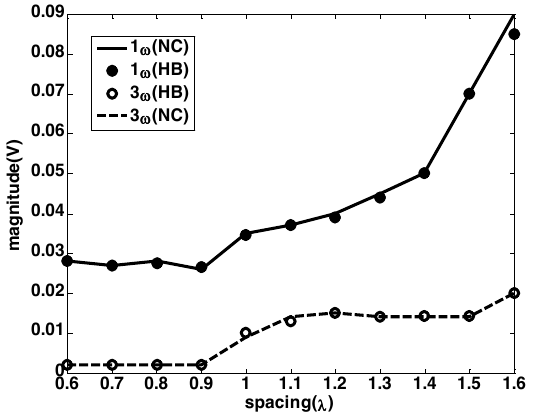
FIGURE 11. Magnitude of induced voltage across the Gun diode under oblique incidence and terminated with Gun diode by NC and HB techniques.